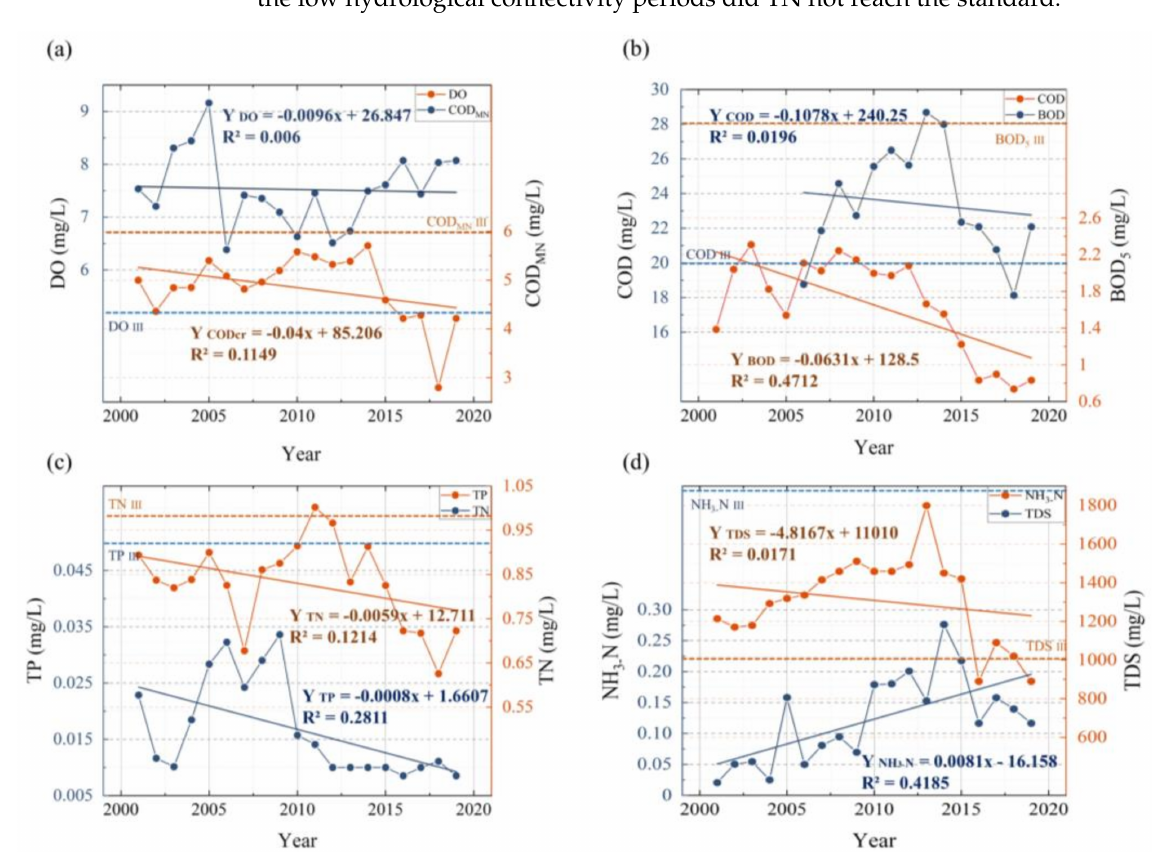
Figure 6. Interannual variation curves of eight water quality indicators, ( a ) DO and COD MN ( b ) COD and BOD 5 ( c ) TP and TN ( d ) NH3-N and TDS, where the dashed lines represent the Class III standard values and freshwater standard values (TDS) of each